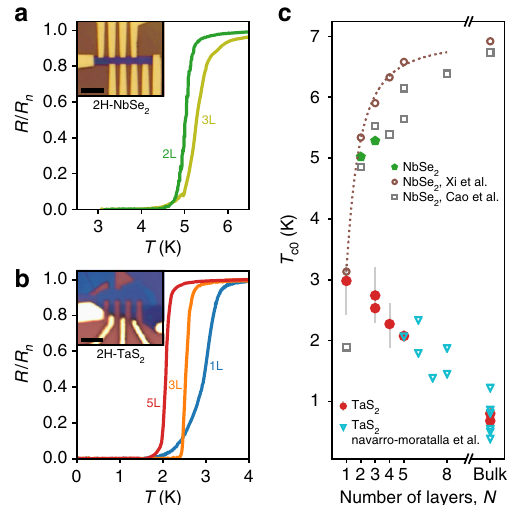
Fig. 2 Superconductivity of atomically thin TaS 2 and NbSe 2 in zero magnetic fi eld. a Temperature dependence of the normalized longitudinal resistance for bilayer (2L) and trilayer (3L) NbSe 2 around the superconducting transition. Optical image of the 3L sample shown in inset. b Resistance of monolayer (1L), trilayer (3L), and fi ve-layer (5L) TaS 2 samples, exhibiting a reverse trend in the T c0 with decreasing thickness. Optical image of 3L sample shown in inset. Scale bars are 4 μ m. c Compilation of superconducting transition temperatures T c0 as a function of thickness for TaS 2 and NbSe 2 samples from this work as well as from Navarro-Moratalla et al. 11 , Xi et al. 4 , and Cao et al. 16 , using 50% of normal state resistance to de fi ne the transitions. Error bars on TaS 2 data denote temperature at 10 and 90% of normal state resistances. Dotted line follows the fi tting curve